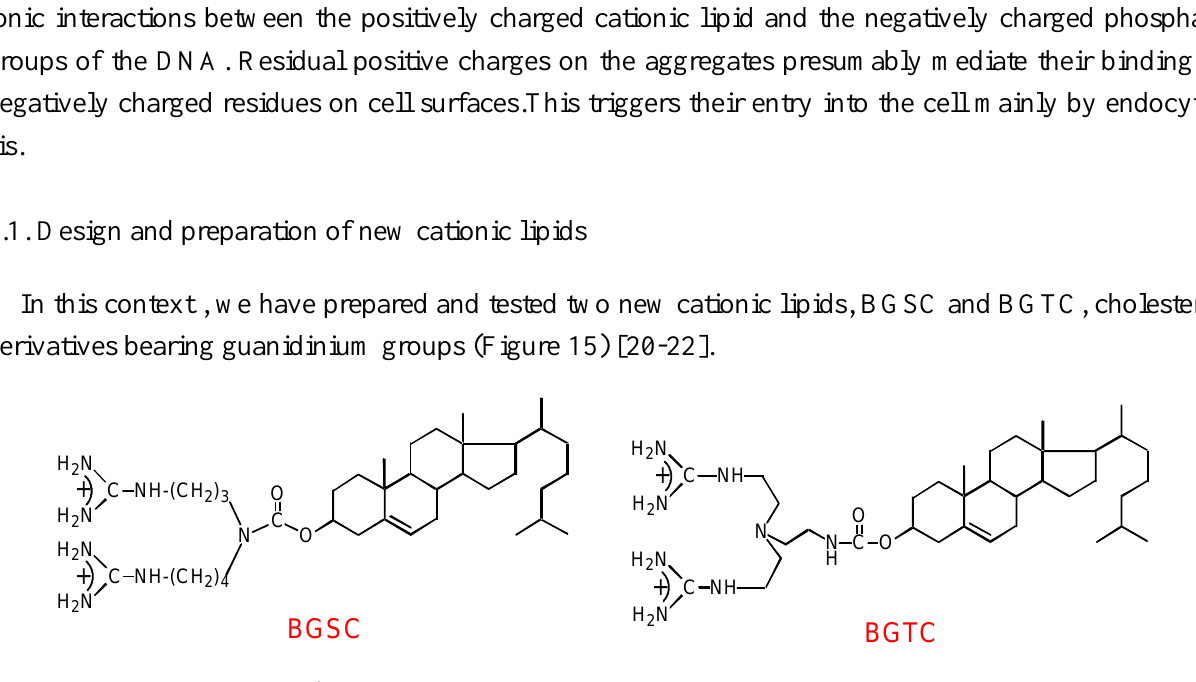
Figure 15. Guanidinium-cholesterol cationic